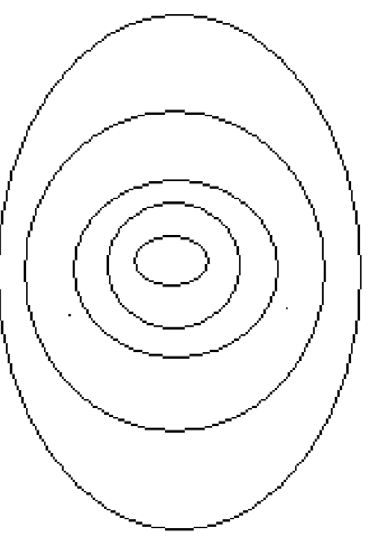
Figure 5. Pictorial representation of isoindicial contours of refractive index in a lens where the contours in the inner regions of the lens are wider in the sagittal than in the equatorial plane.